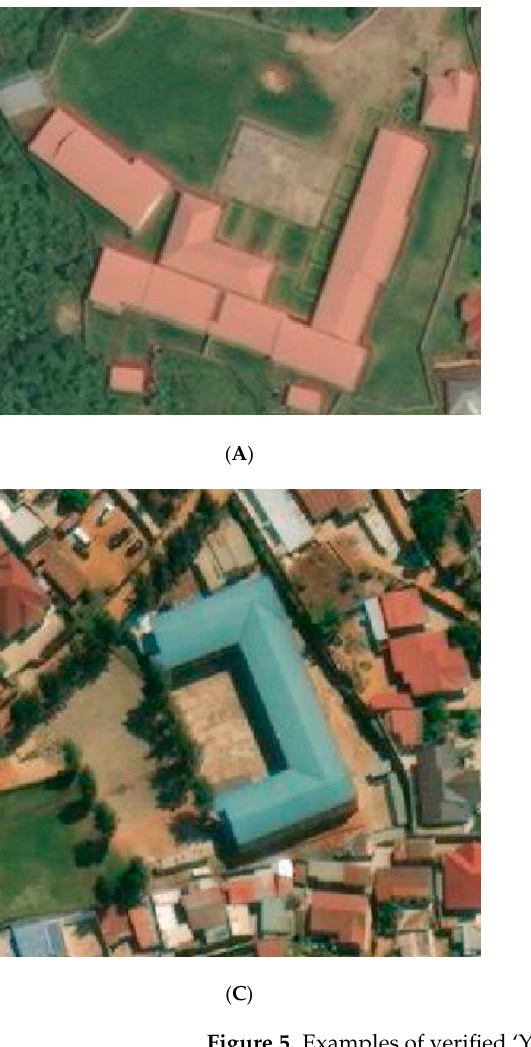
Figure 5. Examples of verified ‘YES’ school image tiles. ( A ) Building with sport fields, ( B ) Group of the same type of buildings, ( C ) Building with U shape, ( D ) Buildings with L shape and empty